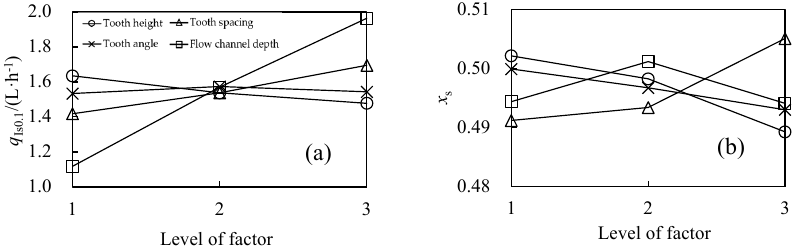
Figure 9. Effect of flow channel structural parameters on ( a ) the simulated flow rate ( q Is0.1 ) and ( b ) flow index ( x s ) of the variable flow emitter in working stage I.